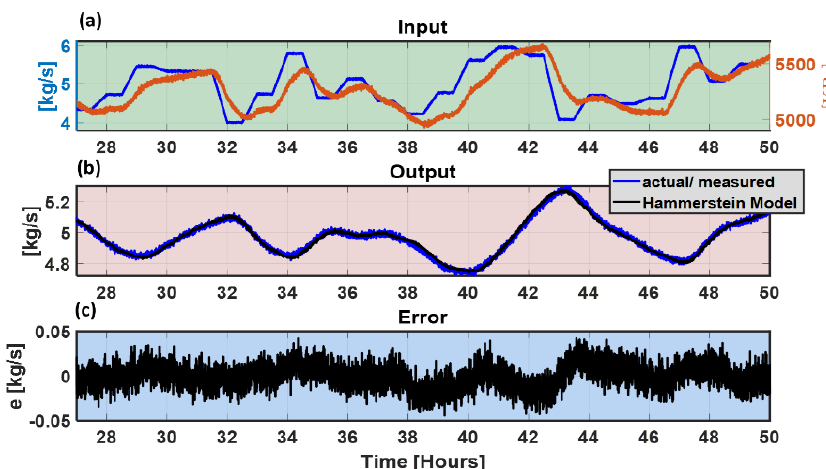
Figure 7. Validation of Hammerstein model with 1201 parameters and noise ratio of 0.2%, ( a ) Pressure and mass flow rate signals at inlet, used as a model input, ( b ) actual mass flow rate signals at outlet, used as a model output. Estimated mass flow rate sign for given input and output signals, ( c ) Modeling errors between actual and estimated mass flow rate.